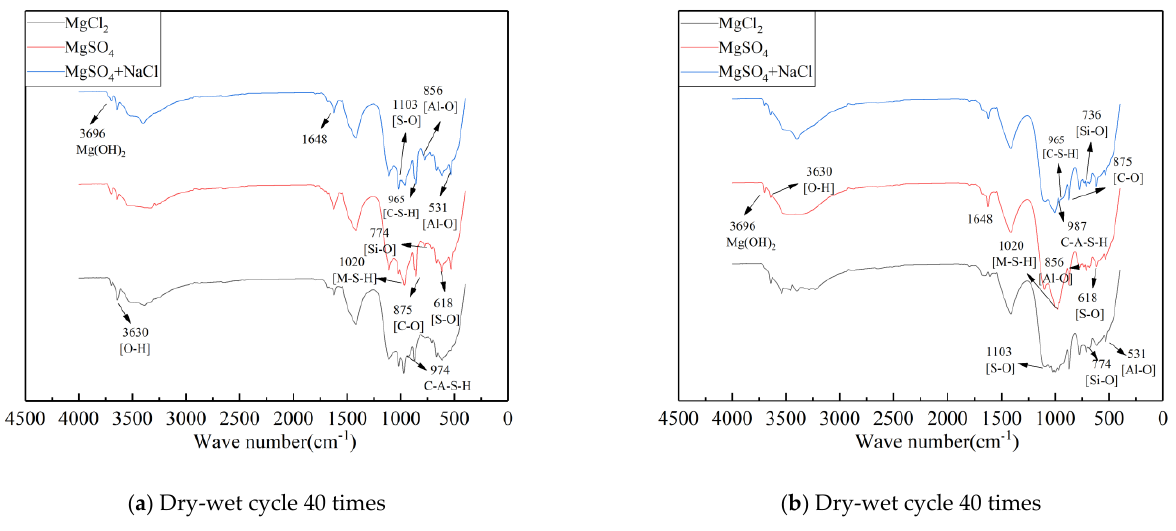
Figure 16. FTIR spectra of concrete corroded by Mg 2+ solution.